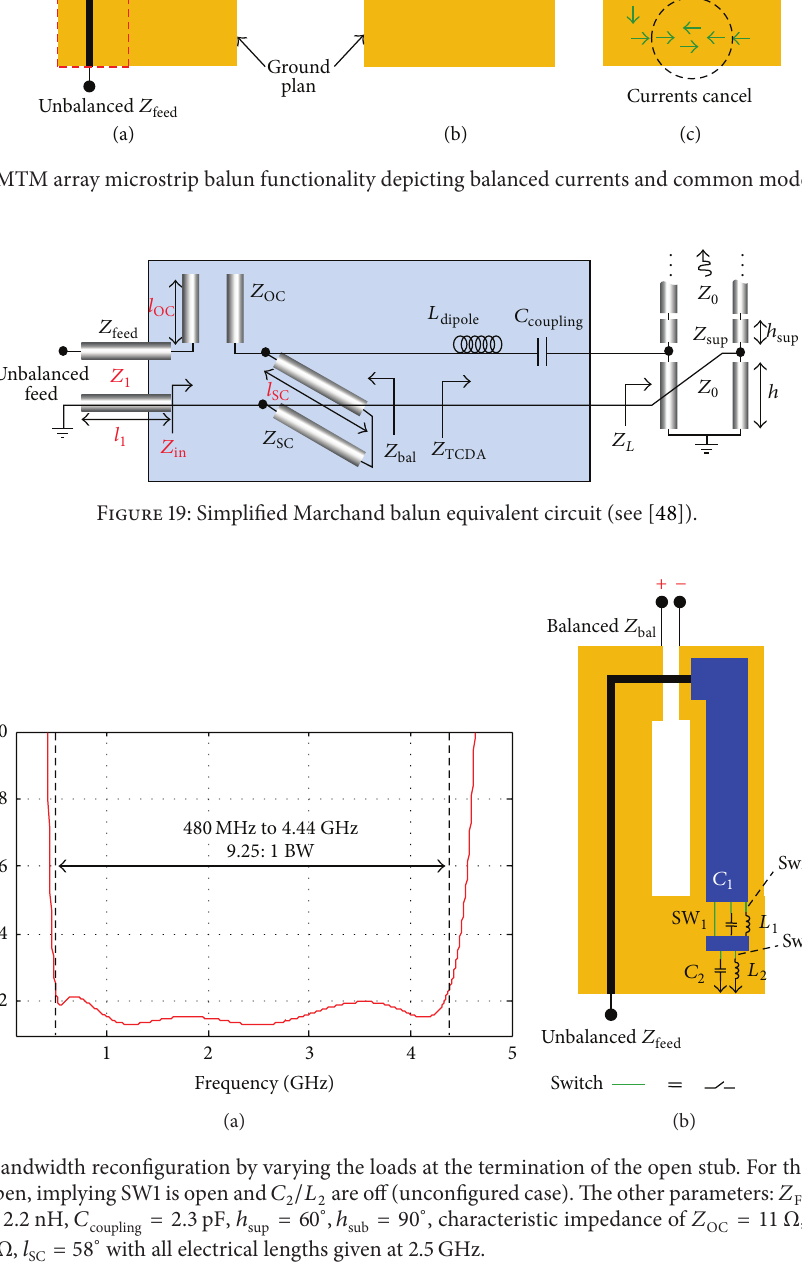
= 100 Ω , 𝑍 = 𝑍 = 0 Feed Sub = 11Ω , 𝑙 = 87 ∘ , characteristic OC oc